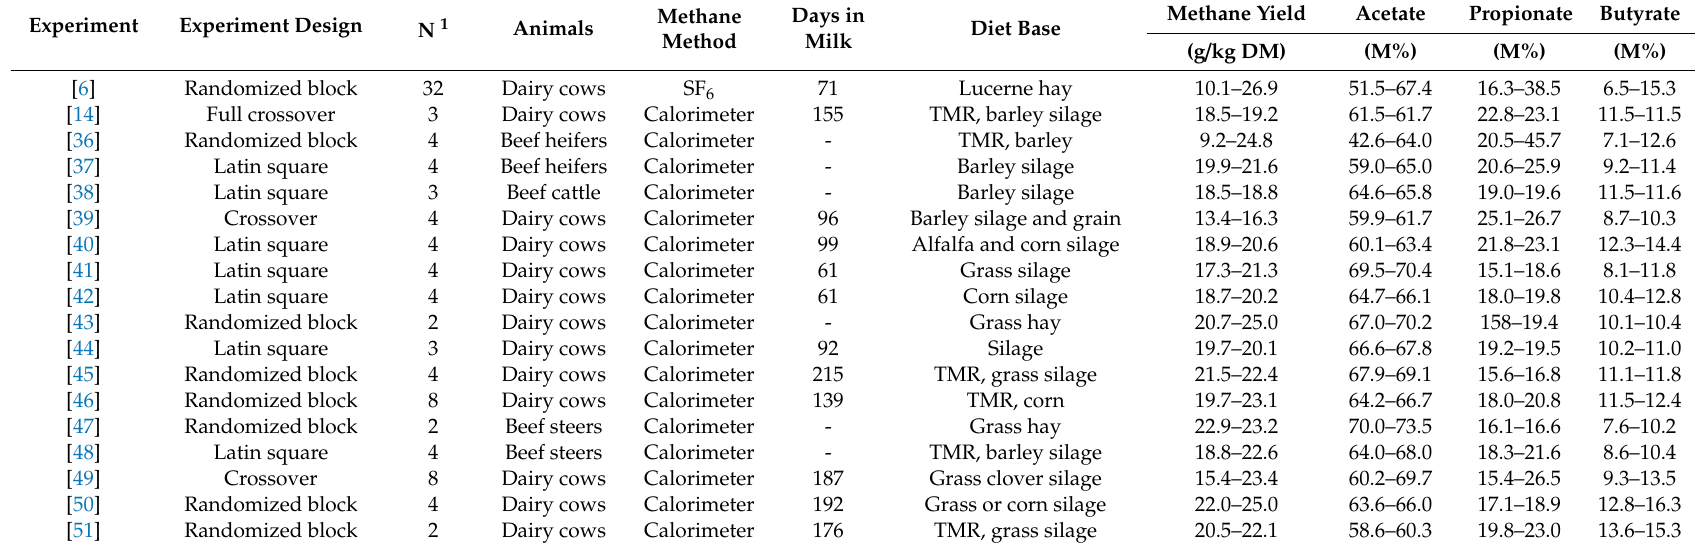
Table 4. Summary of the data used to externally validate the prediction